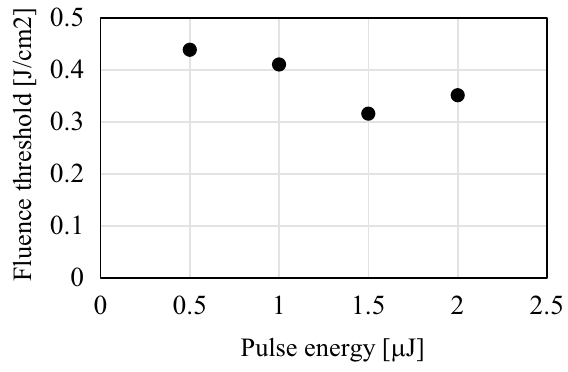
Figure 2. The relationship between pulse energy and fluence